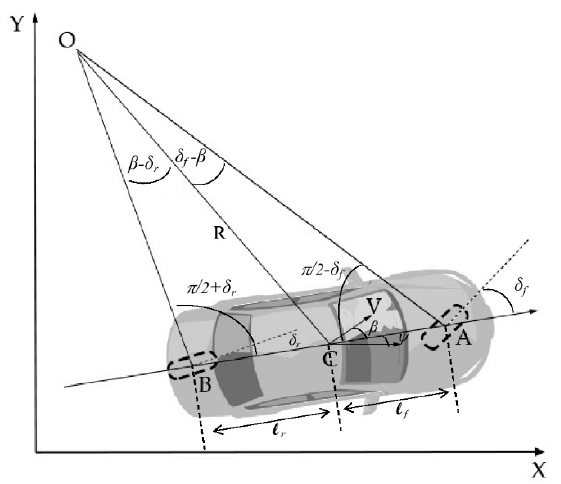
Figure 1. Lateral vehicle motion based on kinematics.